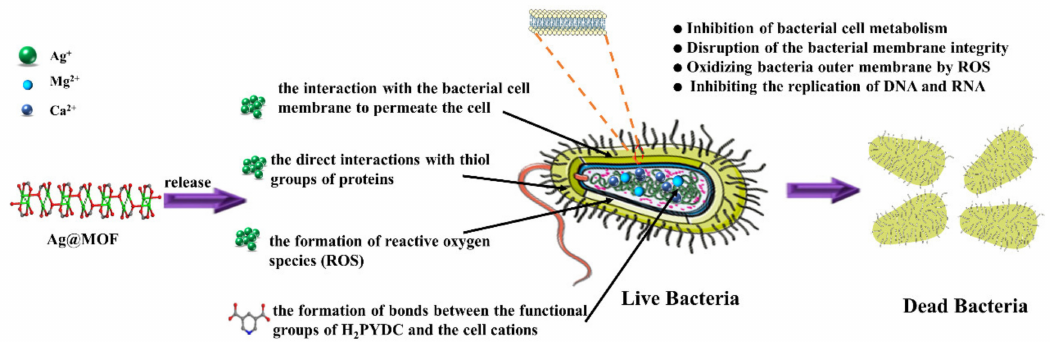
Figure 1. Antibacterial mechanisms of Ag-Metal-Organic Framework